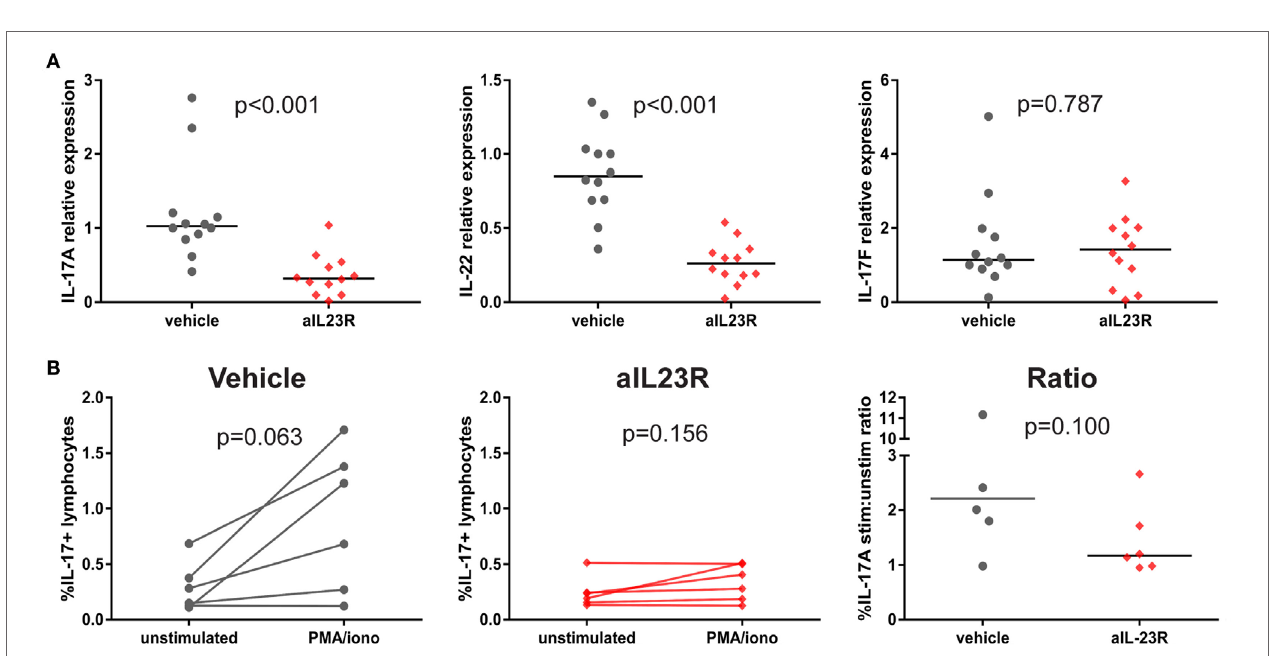
FigUre 4 | Prophylactic treatment with anti-IL23R, effect on downstream molecules in draining lymph nodes. (a) IL-17A, IL-22, and IL-17F gene expression directly ex vivo (B) IL-17A protein in draining lymph nodes in unstimulated (medium only) versus stimulated (PMA/ionomycin) condition in vehicles and aIL23R-treated rats and the ratio between the two groups (individual data points and median are depicted).